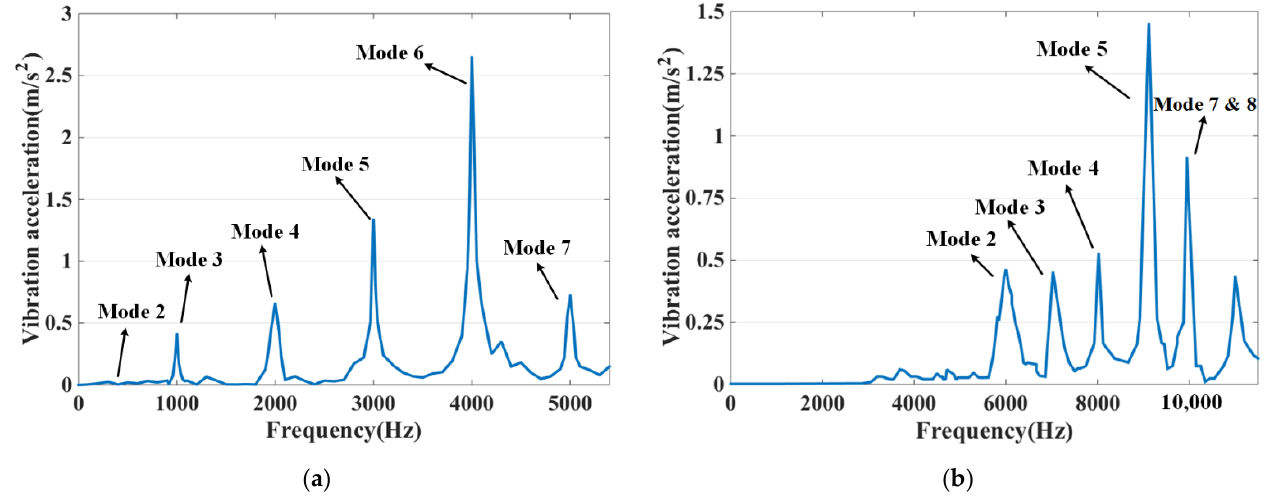
Figure 18. Vibrating surface acceleration at rated speed. ( a ) Outer stator. ( b ) Inner stator.